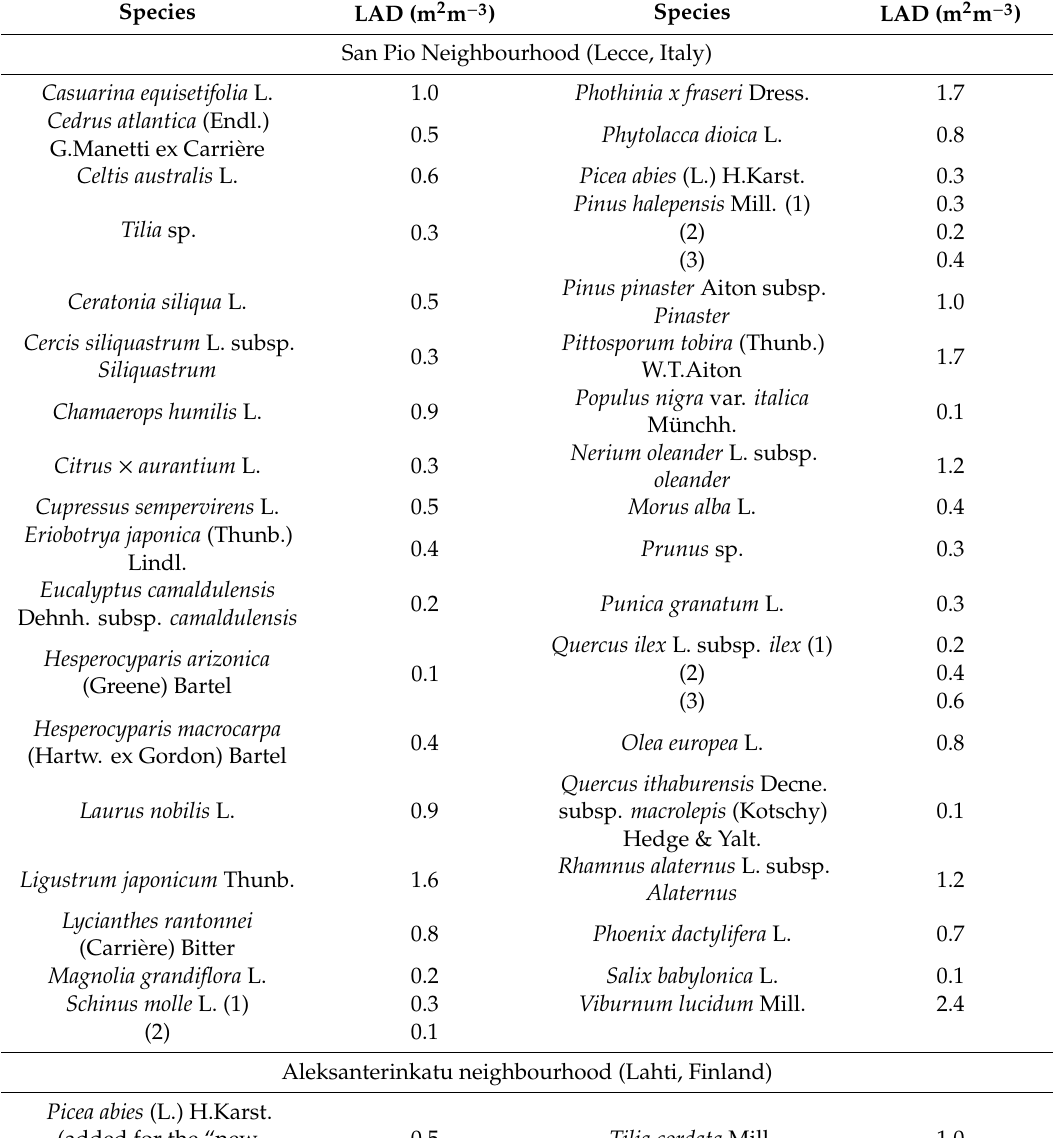
Table 1. List of species identified within the two neighbourhoods with indication of the leaf area density